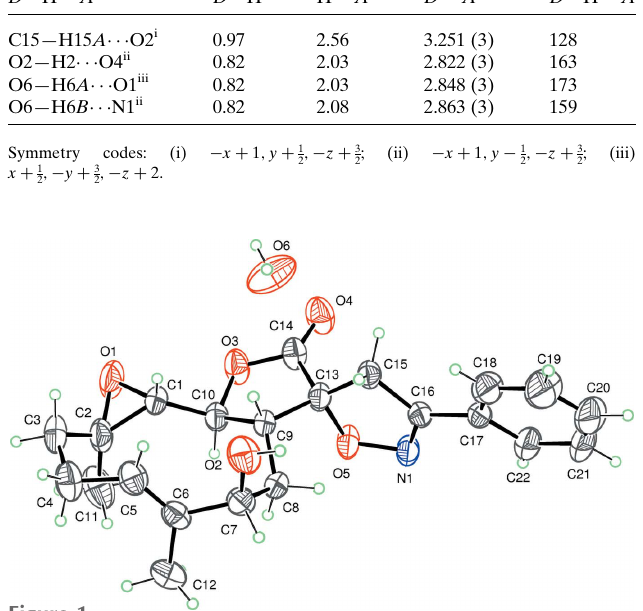
Figure 1 The molecular structure of the title compound, with displacement ellipsoids drawn at the 50% probability